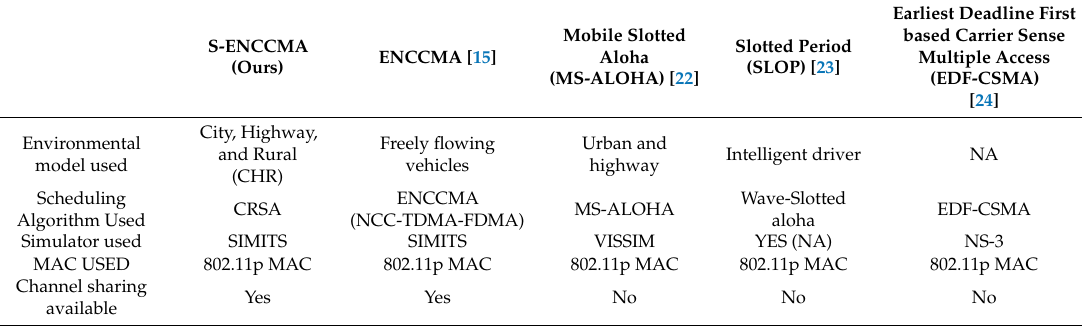
Table 4. Comparison with state